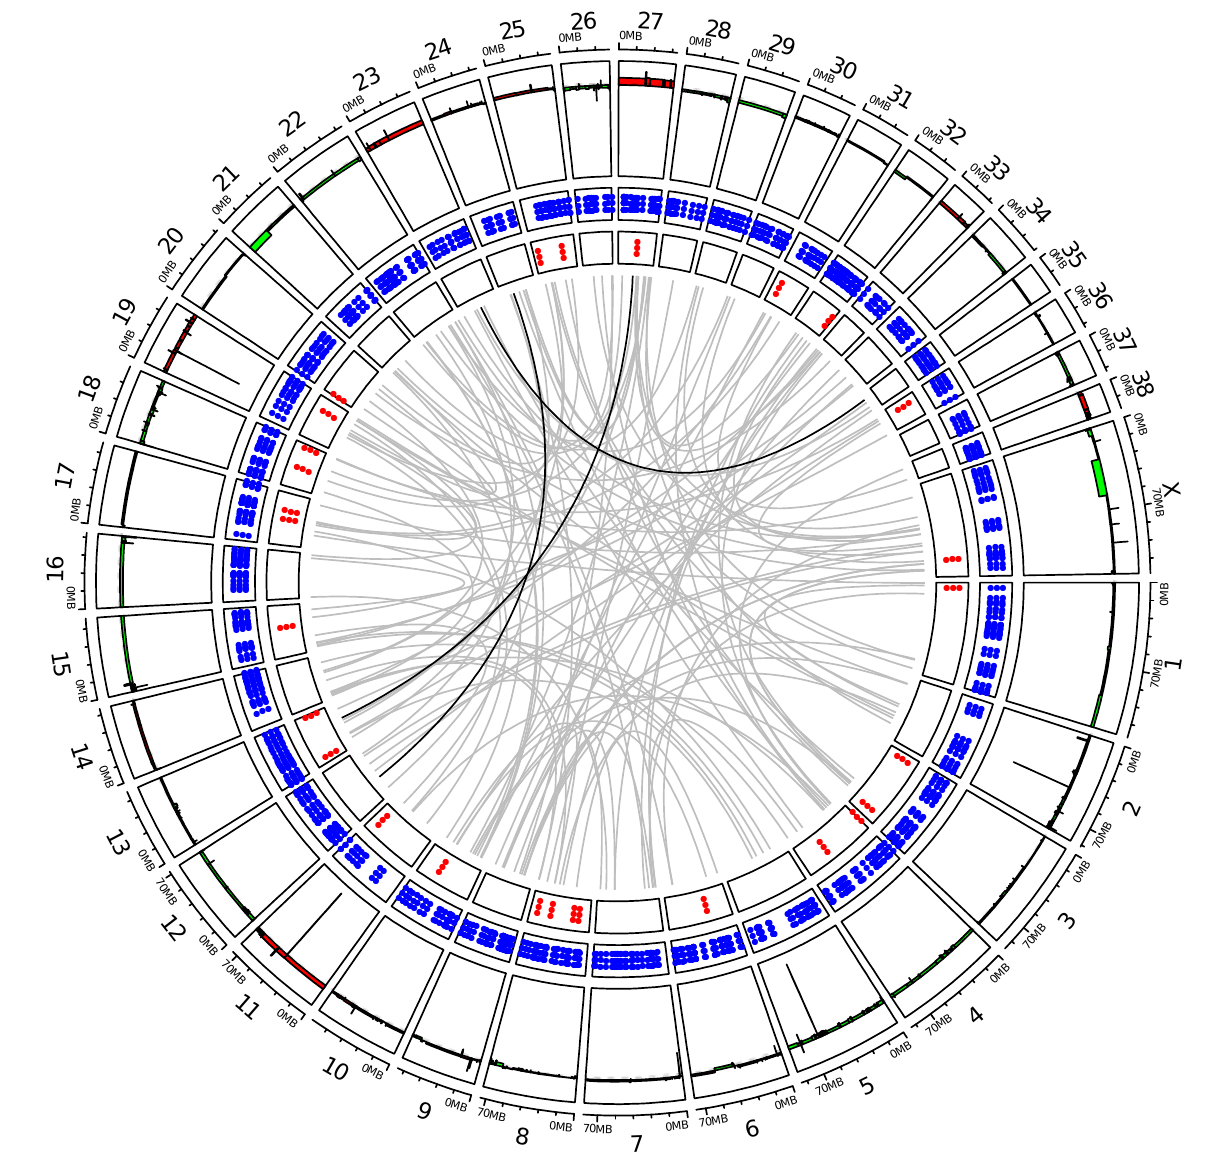
Figure A6. Circos plot representing the distribution of SVs of cell line CML10 along dog chromosomes with, from external to internal layers, CNA gains/losses (in dark red/green), deletions, duplications, insertions, and inversions in blue, light red, orange, and green, respectively. Interchromosomal break-ends (BND) are represented by gray lines connecting chromosomes with a color intensity corresponding to the number of reads validating the SV.